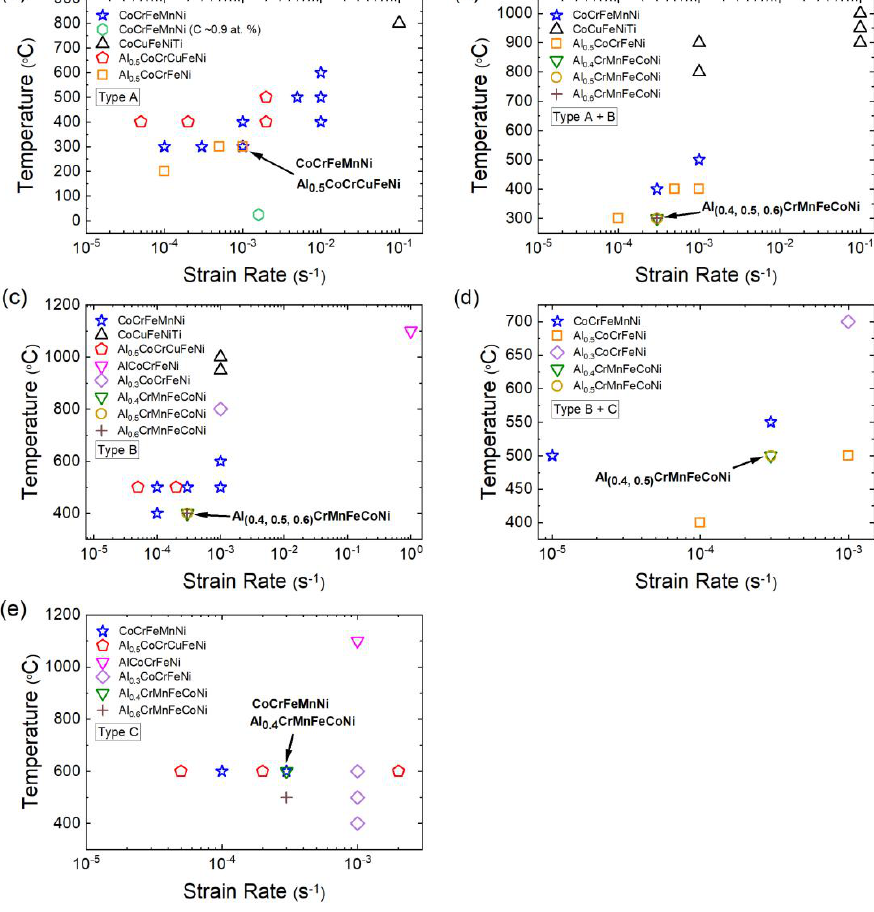
Types ( a ) A, ( b ) B, ( c ) C, ( d ) A + B, and ( e ) B +